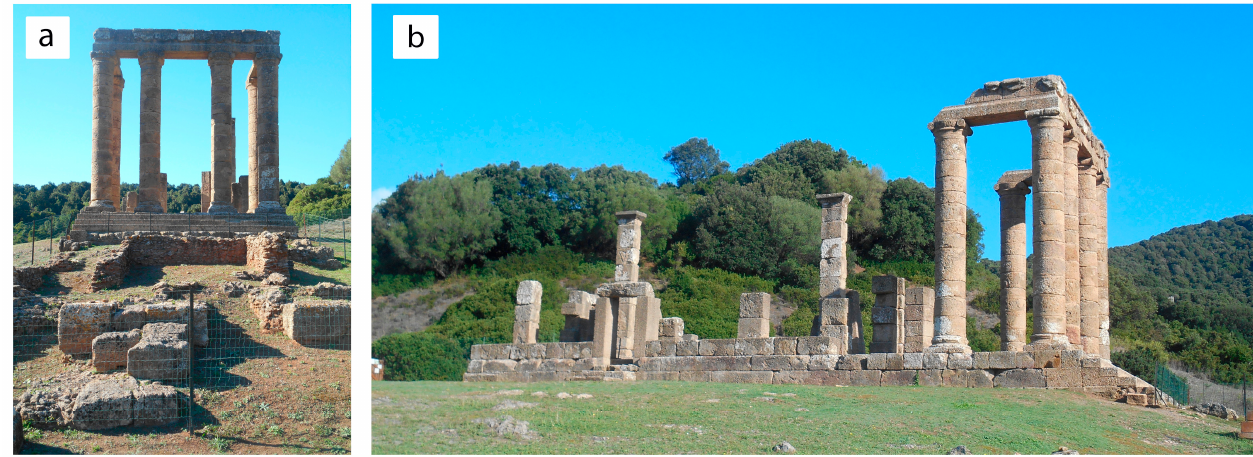
Figure 1. ( a ) Front view of the Punic temple; ( b ) lateral view of the Roman temple.